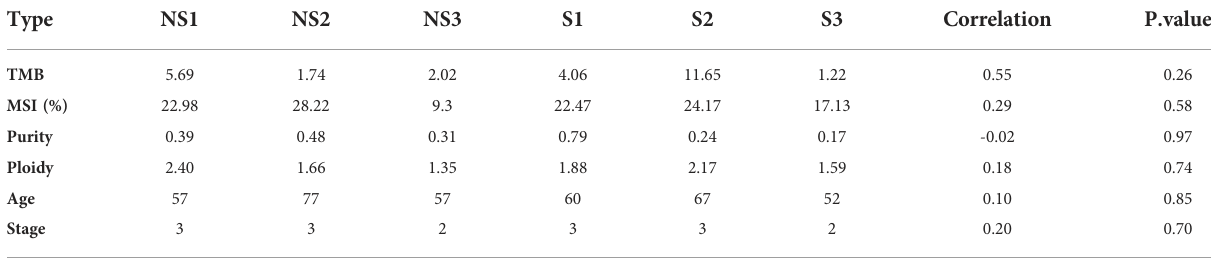
TABLE 2 Difference of TMB, MSI, and purity between radio-sensitive and radio-resistant groups.